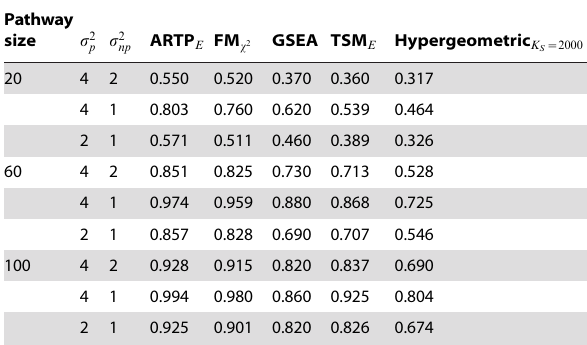
Table 4. Power of the methods for the different pathway